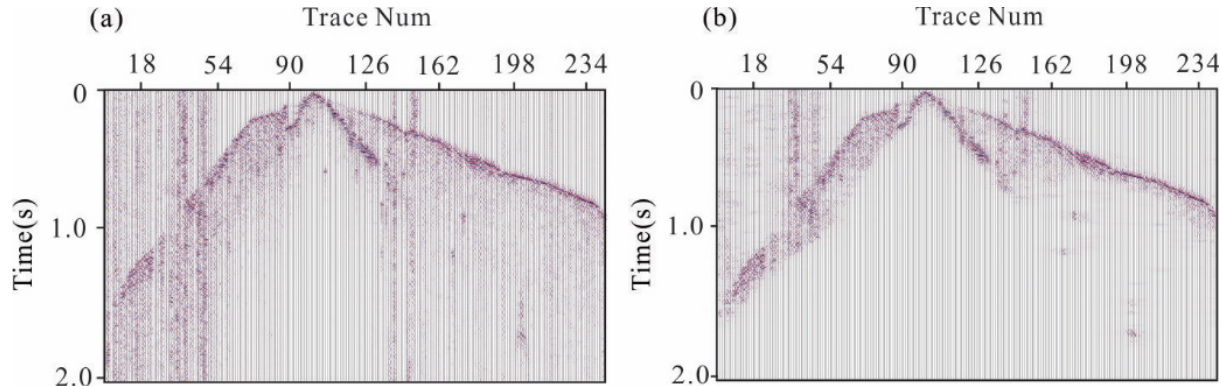
Figure 2. Schematic showing the ( a ) raw and ( b ) processed field